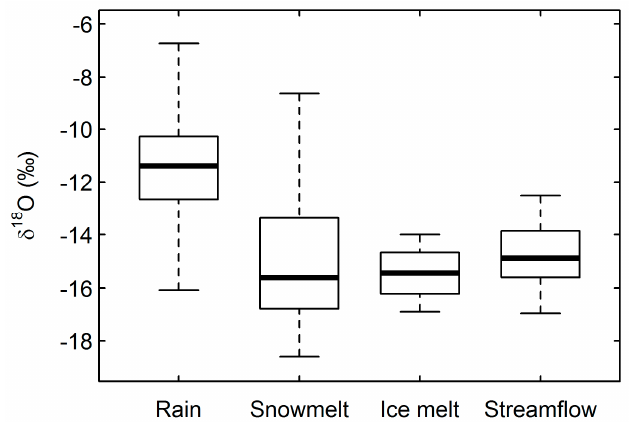
Figure 2. Boxplots of δ 18 O in rain, snowmelt, ice melt and streamflow as used for the application of TRANSEP. Boxplots show the median (thick line), the interquartile range (box) and 1.5 × interquartile range (whiskers).